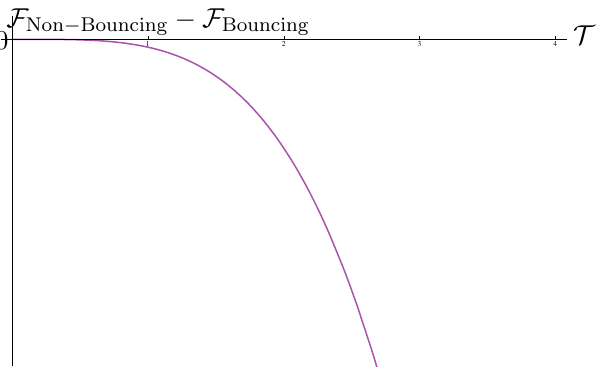
Figure 14 . Free energy di(cid:11)erence as a function of the (dimensionless) temperature between the two branches of black holes emanating from UV 2 with negative source (dashed and solid purple curves in (cid:12)gures 11 and